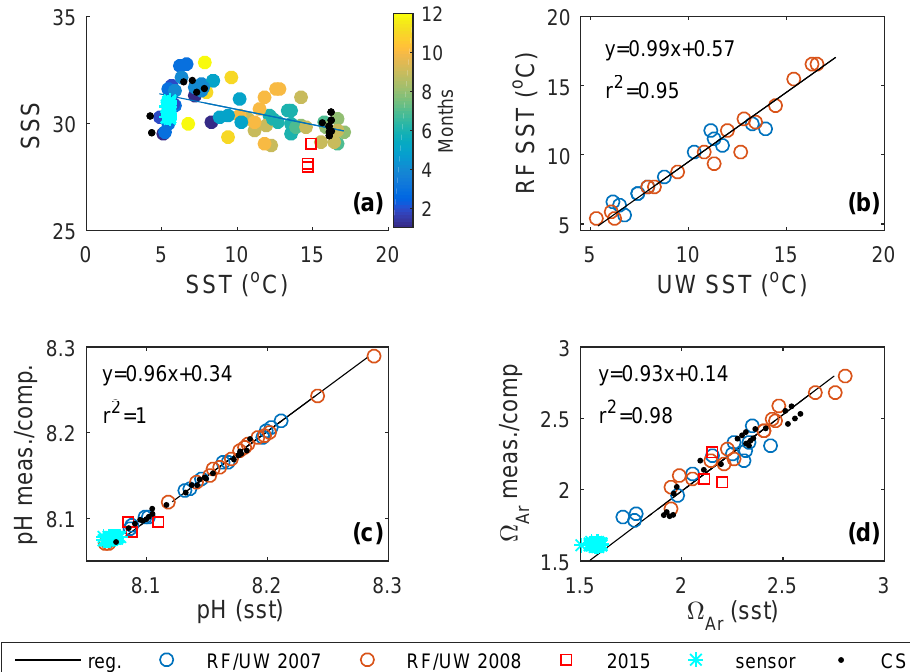
Figure 2. (a) RF SSS as a function of SST (filled symbols) with the regression line described by Eq. (1). Sampling month is indicated by the colour of the data points. The CS (dots), 2015 (squares), and sensor (stars) data sets are also shown for comparison with the regression line. (b) Compares RF SST with chronologically co-located UW SST acquired from the whole study area during 2008 (blue) and 2007 (red). (c) Compares pH(sst) with pH values that have been measured or computed from TA and DIC. Symbols are as in Fig. 1. (d) Compares (cid:127) Ar (sst) with (cid:127) Ar values that have been computed from measured TA and DIC or from measured pH and UW f CO 2 . Symbols are as in Fig. 1. In the legend, “reg.” means regression